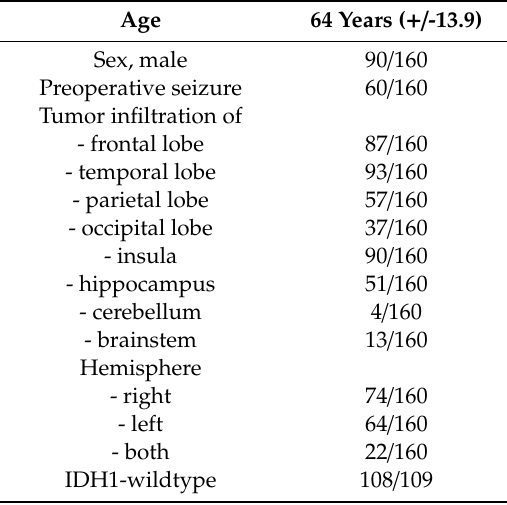
Table 1. Baseline patient and tumor